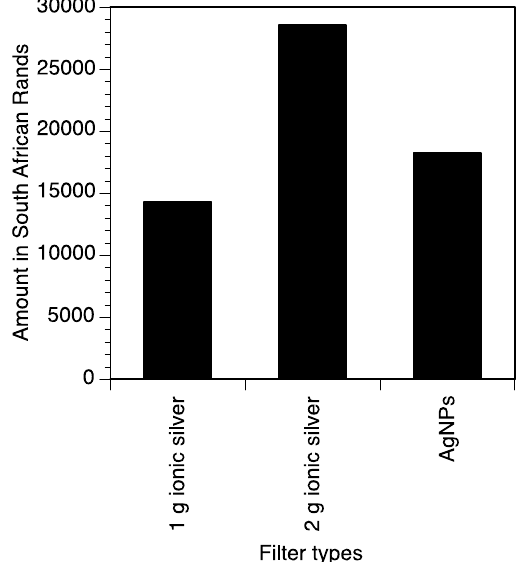
Figure 9. Costs associated with producing 1000